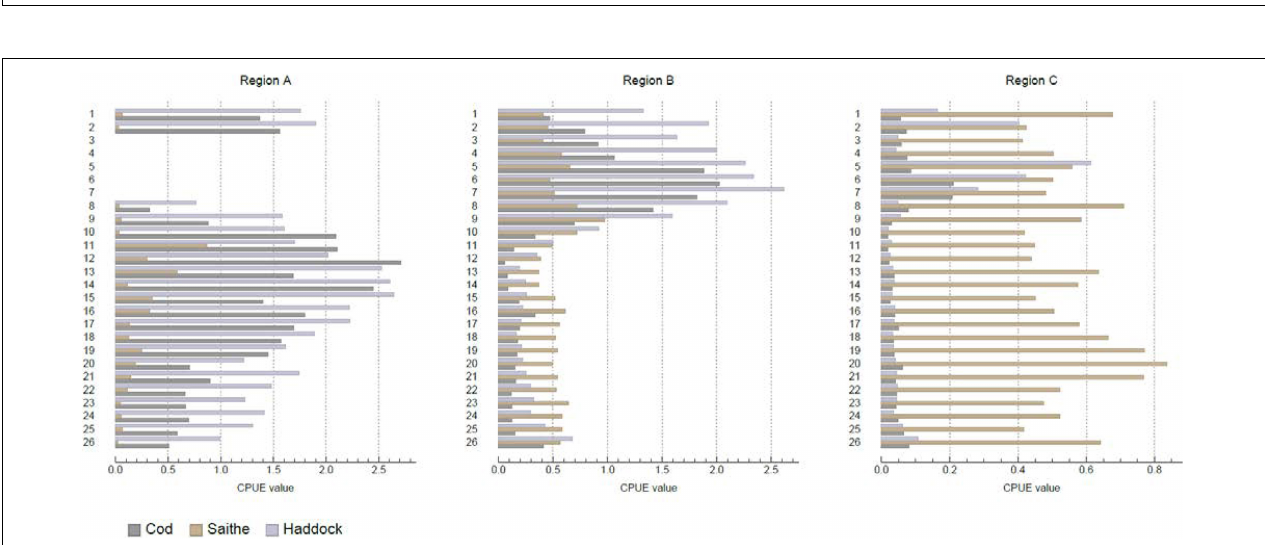
Frontiers in Marine Science |